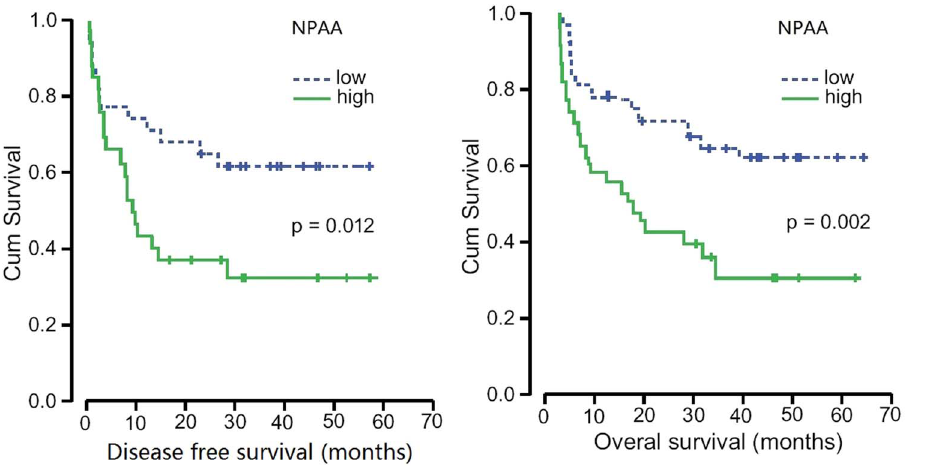
Figure 2. Kaplan-Meier curves of survival differences among NSCLC patients. Disease-free survival (A) and Overall survival (B) for low NPAA and high NPAA patients. P values were determined by the log-rank test.